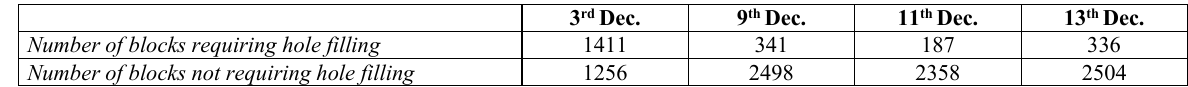
Table 1. Local displacements of Scan Stations 3 and 4 as measured by total station.